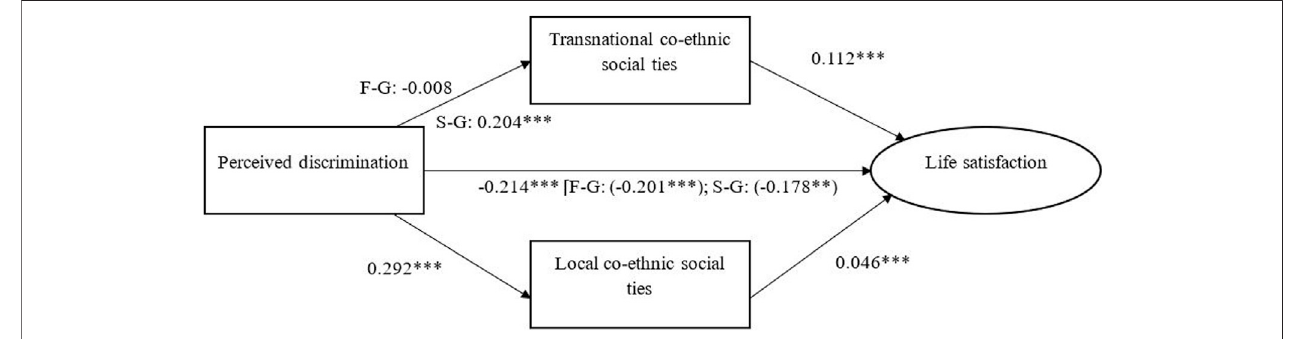
FIGURE 2 | Path diagram of directing and meditating fi rst and second generation Turkish Morrocon Minorities. Note: F-G and S-G are stands for fi rst and second generationrespectievly.Totaleffectarereportedfortwogroupsintheparenthesis.Re fl ectivelatentvariablesarerepresentinthecircle** p < 0.01,*** p <